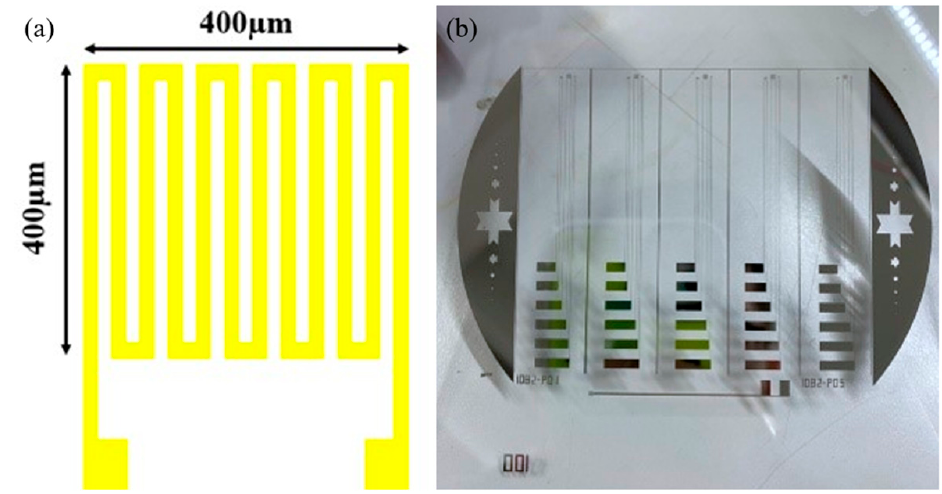
Figure 2. (a) Design diagram of the flexible micro air velocity sensor; (b) Mask layout of the flexible micro air velocity sensor.